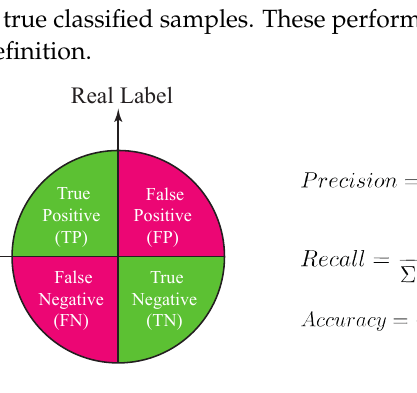
Figure 8. Performance metrics